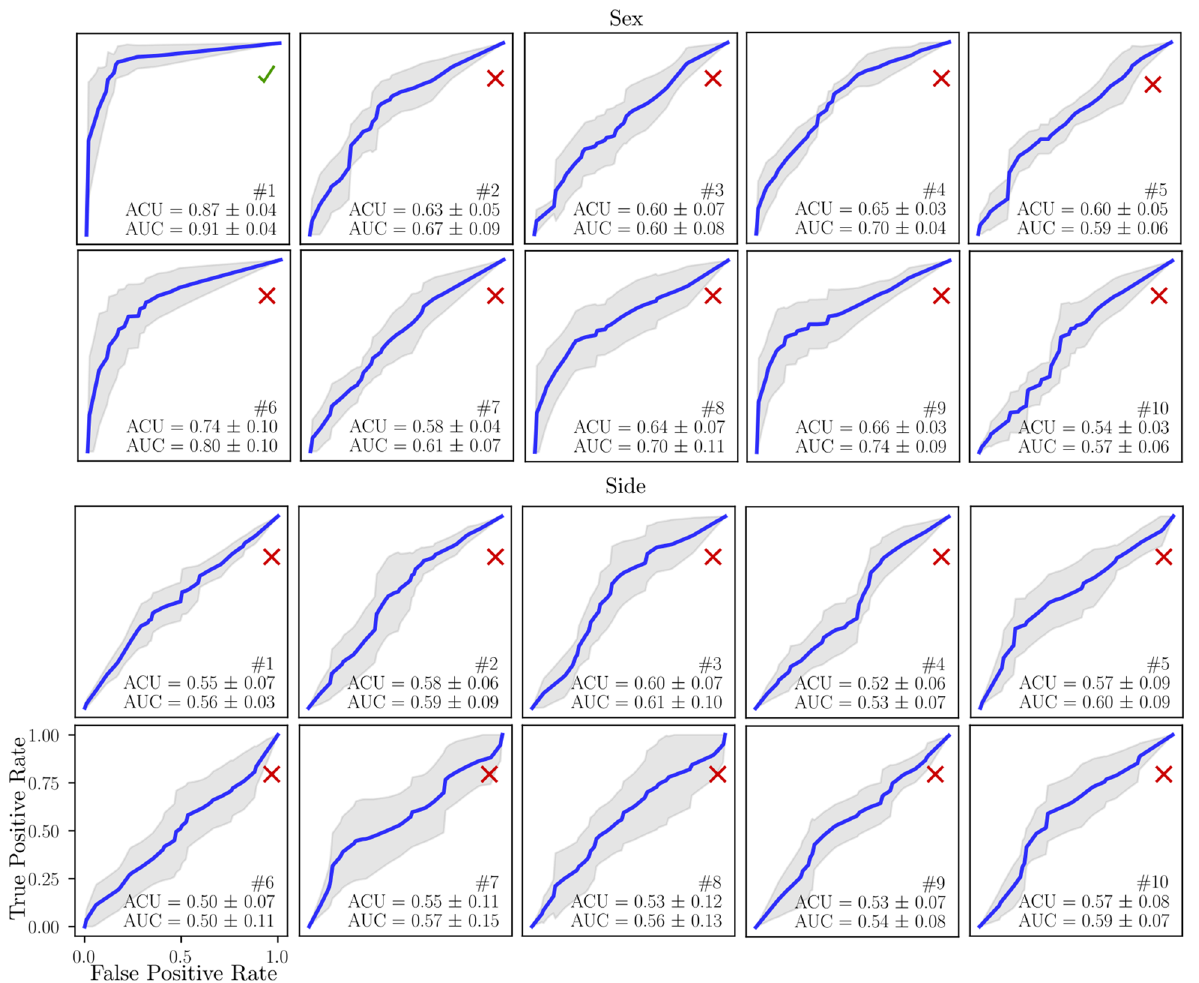
Figure 2. The sex and side classification ability of ten modal stiffnesses s for model FEMP-I. The blue curves indicate mean values ROC, grey fill the standard deviation. The mean ACU/AUC with standard deviation is computed within cross-validation